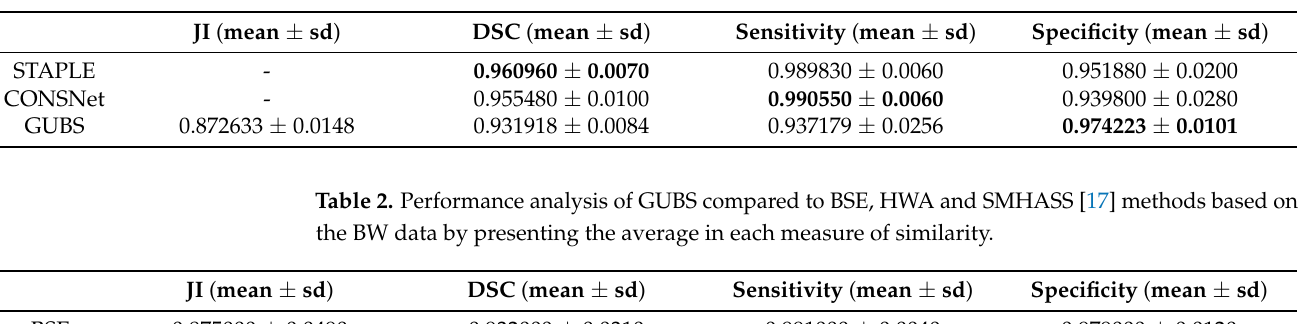
Table 1. Performance analysis of GUBS compared to STAPLE and CONSNet [9] methods based on the OASIS data set by presenting the average in each measure of similarity.